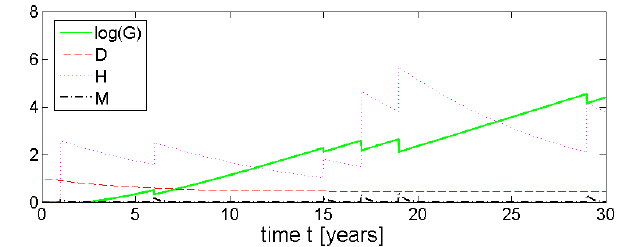
Figure 3. A simulation of the key dynamics of Viglione et al. (2014) using the original random rainfall events. It shows economic wealth G , distance D , height of levees H and memory M